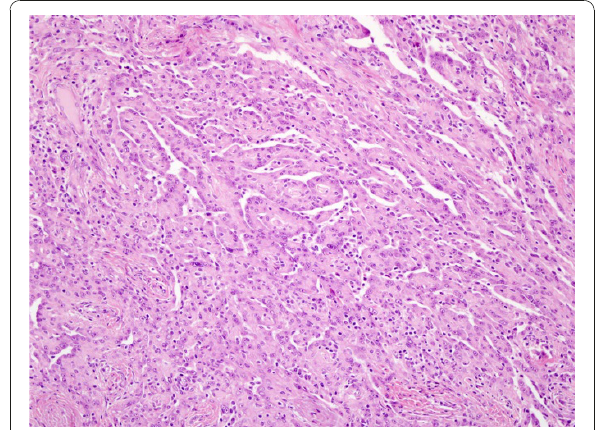
Figure 1 Malignant mesothelioma, epithelioid variant . The tumor exhibits papillary and tubular pattern (H&E, original magnification ×